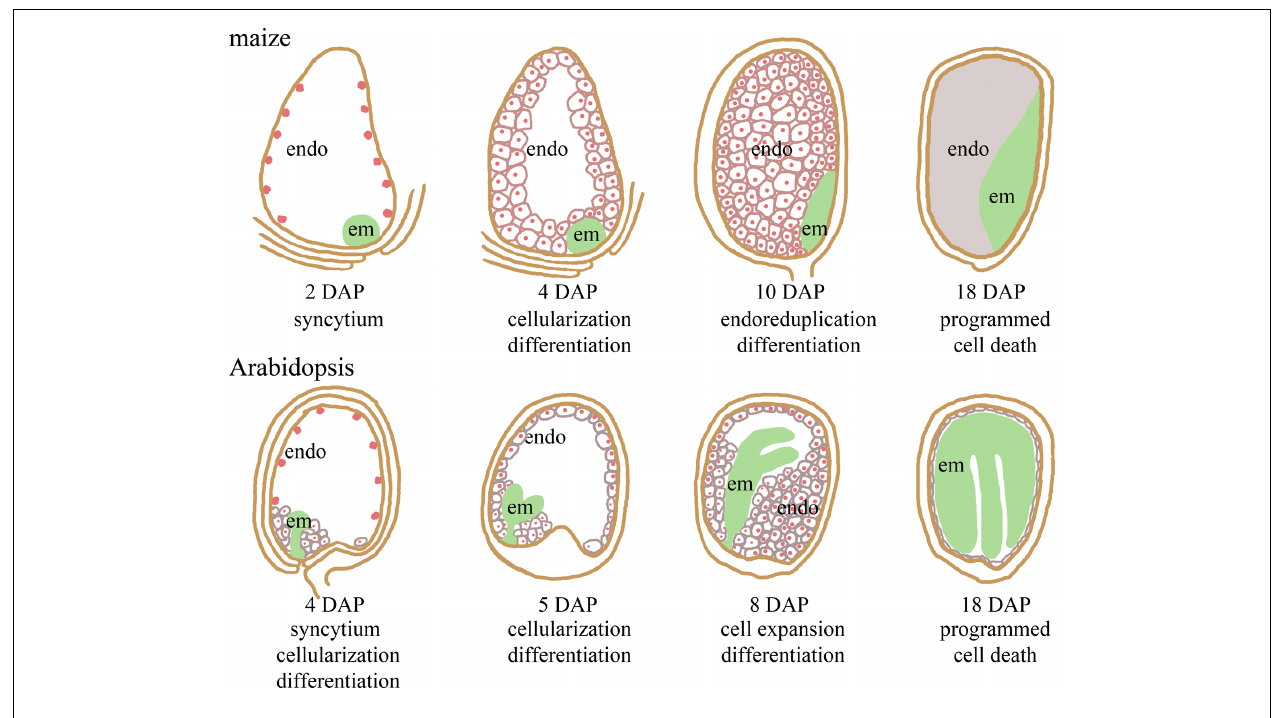
is complete. In maize, the endosperm is persistent and undergoes programmed cell death starting around 18 days after pollination (DAP). The Arabidopsis embryo consumes most of the endosperm prior to seed maturation. Endosperm (endo) nuclei are indicated in red. The embryo (em) is in green.